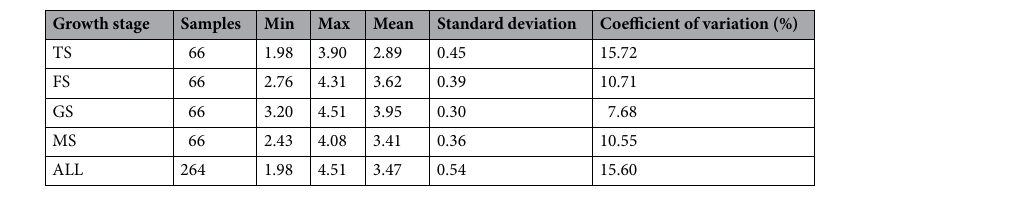
Table 3. Descriptive statistics of the measured